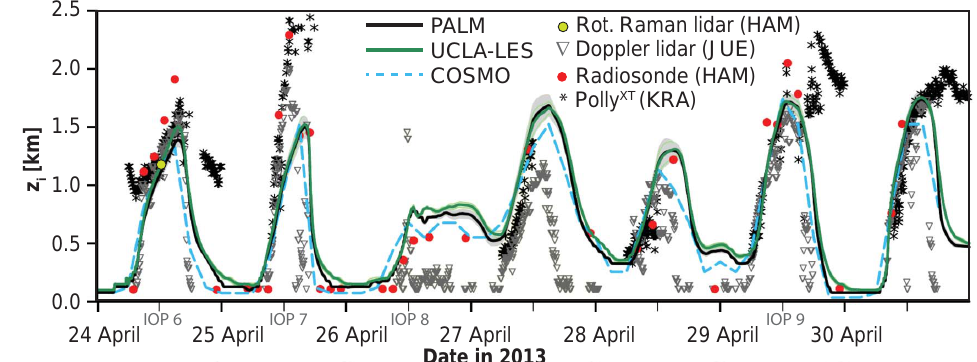
Figure 16. Temporal evolution of the boundary layer depth z i for the period from 24 to 30 April 2013. z i is determined by means of the bulk Richardson number criterion in all three models (PALM, UCLA-LES, and COSMO) and in the radiosonde data. A criterion based on the vertical-velocity variance and detected aerosol layers is used for the wind lidar and aerosol lidar PollyXT, respectively. The data point obtained from the temperature rotational Raman lidar (TRRL) is based on Behrendt et al. (2015). Radiosondes were launched at the KITcube site, while the Doppler lidar and Polly XT took measurements at sites JUE and KRA, respectively. Grey and green shading denotes twice the standard deviation of z i in PALM and UCLA-LES, respectively. Adopted from Heinze et al.